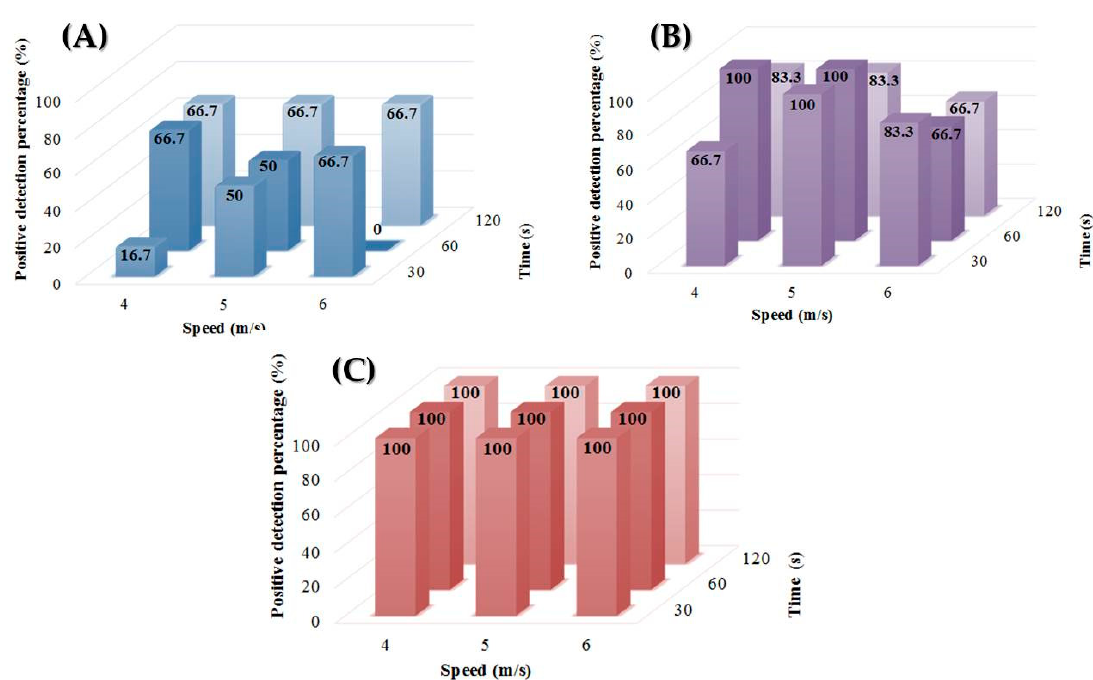
Figure 1. The proportion of positive samples (%) according to the speed and duration of mechanical pretreatment for the concentration of ( A ) 5 oocysts/mL, ( B ) 10 oocysts/mL, and ( C ) 50 oocysts/mL.